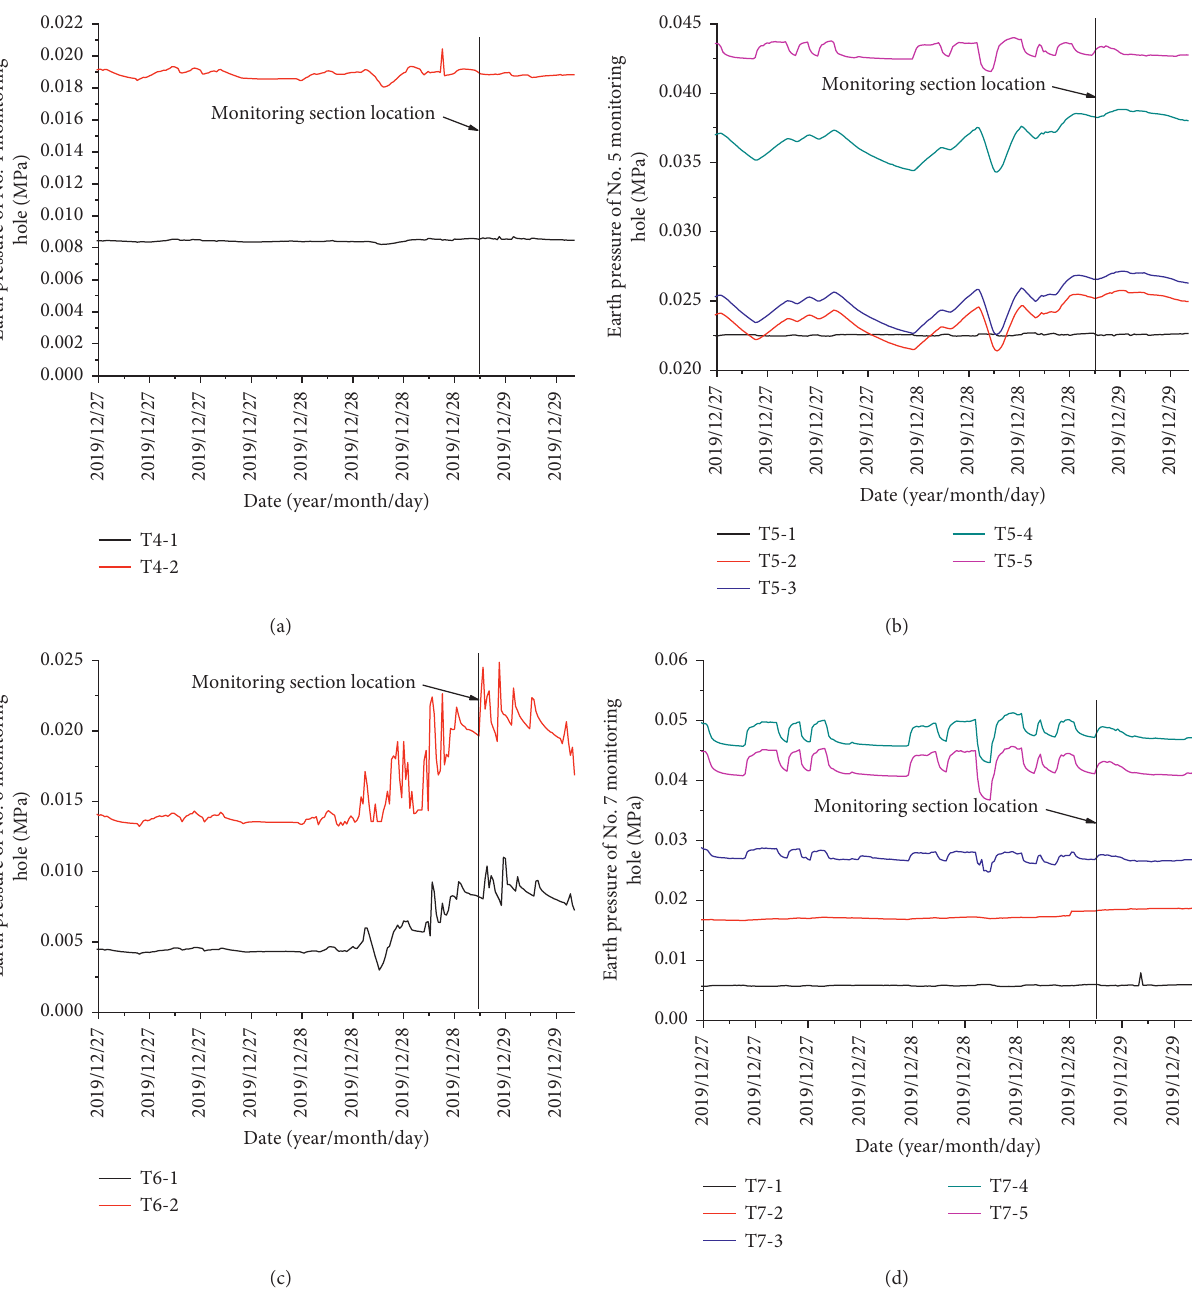
Figure 11: Variation diagram of earth pressure during Hole 3 jacking. (a) Earth pressure of No. 4 monitoring hole. (b) Earth pressure of No. 5 monitoring hole. (c) Earth pressure of No. 6 monitoring hole. (d) Earth pressure of No. 7 monitoring